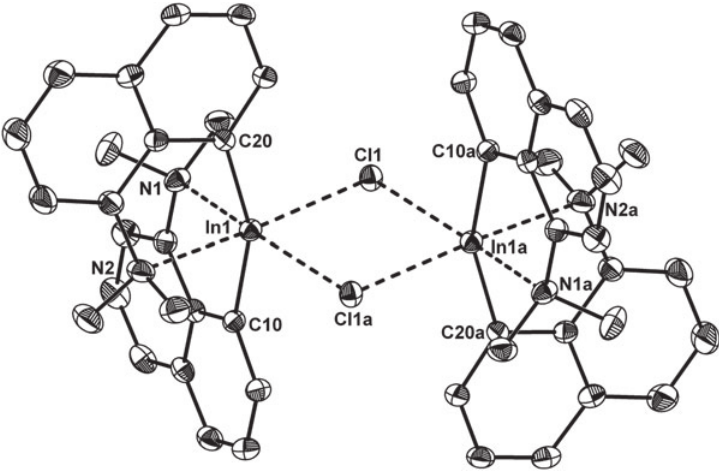
Figure 1 Molecular structure of 1 showing 30 % probability displacement ellipsoids and the atom numbering. Symmetry code used to generate equivalent atoms: a = -x, -y, -z. Selected bond parameters [ Å , ° ]: In1-Cl1 2.669(5), In1-Cl1a 2.710(4), In1-N1 2.550(4), In1-N2 2.620(5), In1-C10 2.137(5), In1-C20 2.146(4), Cl1-In1-Cl1a 80.1(1), Cl1-In1-N1 89.7(1), Cl1-In1-N2 169.59(6), Cl1a-In1a-N1 165.65(6), Cl1a-In1a-N2 94.4(1), Cl1-In1-C10 98.9(2), Cl1-In1-C20 98.8(2), Cl1a-In1-C10 96.1(2), Cl1a-In1-C20 98.9(2),